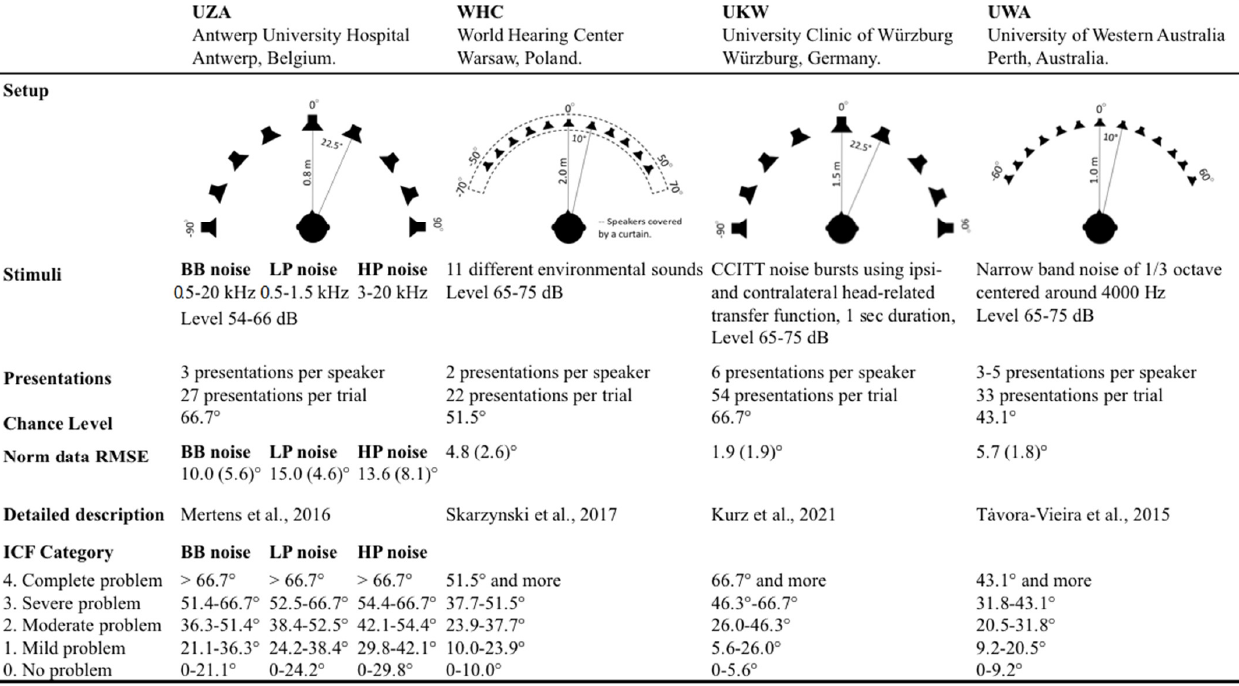
Figure 2. Schematic of the variations in localization test procedures. RMSE: root-mean-square error, BB: broadband, LP: low-pass, HP: high-pass [10,20,27,28].